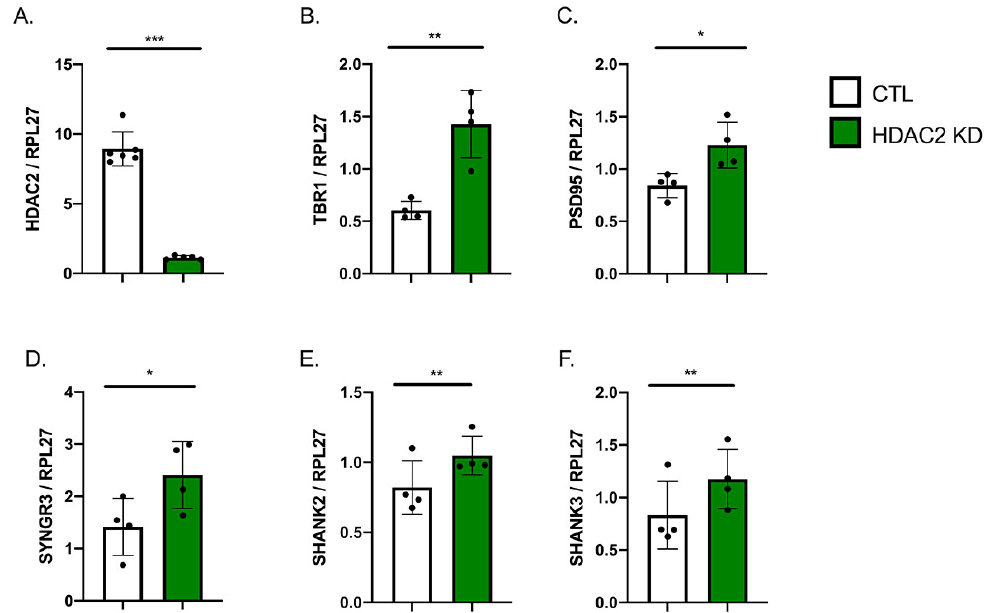
Figure 2. HDAC2 KD in hiPSC-derived neurons influences neuronal and synaptic gene expression. ( A ). Lentiviral transduction in hiPSC-Ns with an shRNA to HDAC2 significantly reduces HDAC2 mRNA. ( B ). Knock-down of HDAC2 (HDAC2 KD) increases mRNA of TBR1 , a gene that influences cortical neuron identity. ( C – F ). HDAC2 KD increases expression of synaptic genes PSD95 ( C ), SYNGR3 ( D ), SHANK2 ( E ), and SHANK3 ( F ). HDAC2 KD vs. CTL neurons (Each dot represents the mean of 4–6 independent experiments, *** p <0.001 by t -test, ** p < 0.01 by t -test, * p < 0.05 by t -test).